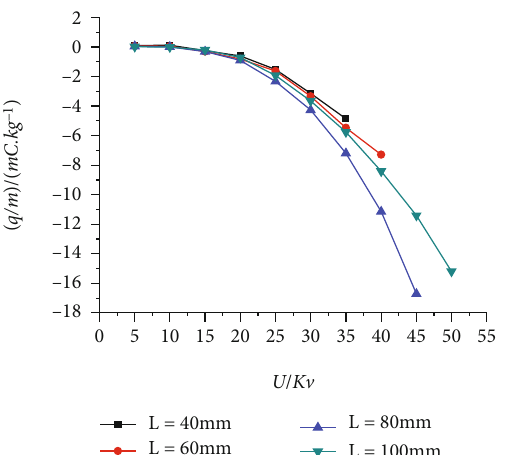
Figure 7: Corona voltage of e ff ect on charge-mass ratio with water mist.